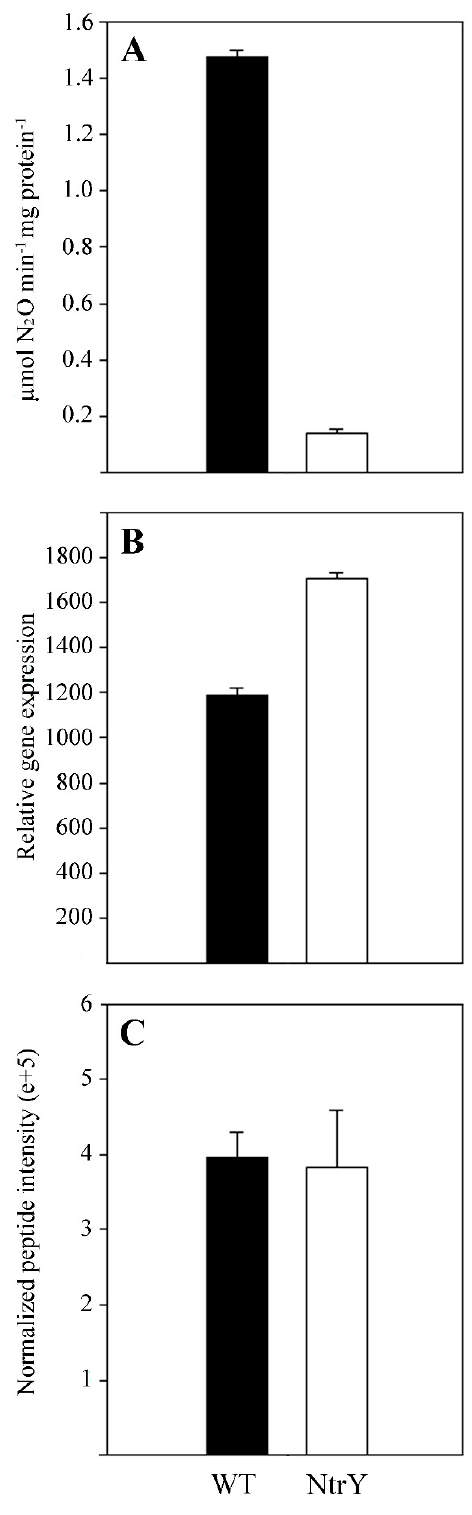
Figure 2. Nitrous oxide reductase in the P. denitrificans wild-type strain and NtrY mutant . The P. denitrificans wild-type strain (black) and NtrY mutant (white) were grown in minimal media with 30 mM nitrate as the sole nitrogen and energy source under anaerobic conditions. Cells were harvested upon reaching an OD 600 of 0.3. ( A ) Nitrous oxide reductase activity was assayed as described in Material and Methods section. ( B ) Transcriptional expression of the nosZ gene was determined by qRT-PCR. ( C ) NosZ peptides quantification was obtained from the quantitative proteomic analysis. Error bars correspond to data from three independent replicates (n =